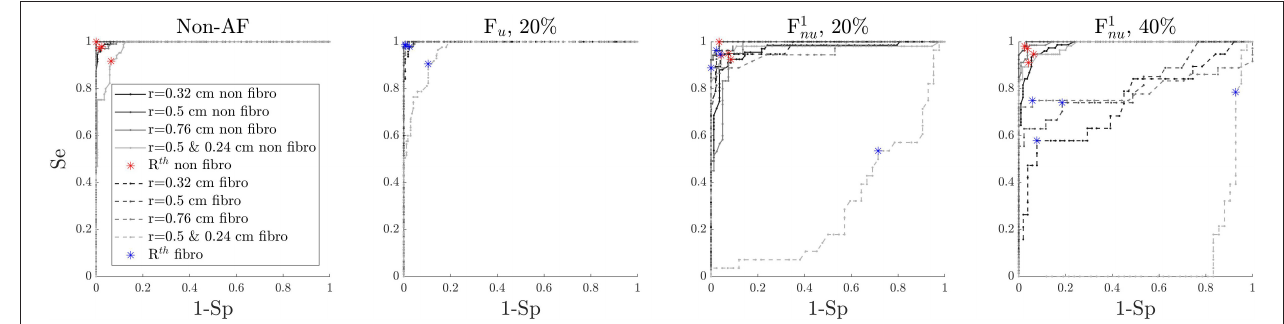
FIGURE 8 | Repolarization wave analysis. ROC curves for non-AF tissues and PxAF and PsAF tissues with 20% uniform diffuse or type 1 fibrosis and 40% type 1 fibrosis. Results for different sizes of ACh sites are presented. Optimal thresholds R th thresholds are shown in red and blue. For Fnu F p , cases, the curves for both the fibrotic (dashed lines) and non-fibrotic (continuous lines) regions are represented in the same plot.